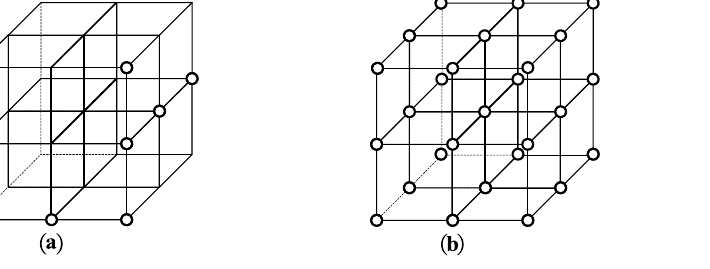
Figure 3. L 3 3 Distribution of experimental points with different design methods. ( a ) One-factor-at-a- Figure 3. 𝐿 (cid:2871) (cid:3119) Distribution of experimental points with different design methods. ( a ) One ‐ factor ‐ at ‐ time experiment. ( b ) Comprehensive experiment. ( c ) Orthogonal a ‐ time experiment. ( b ) Comprehensive experiment. ( c ) Orthogonal experiment.